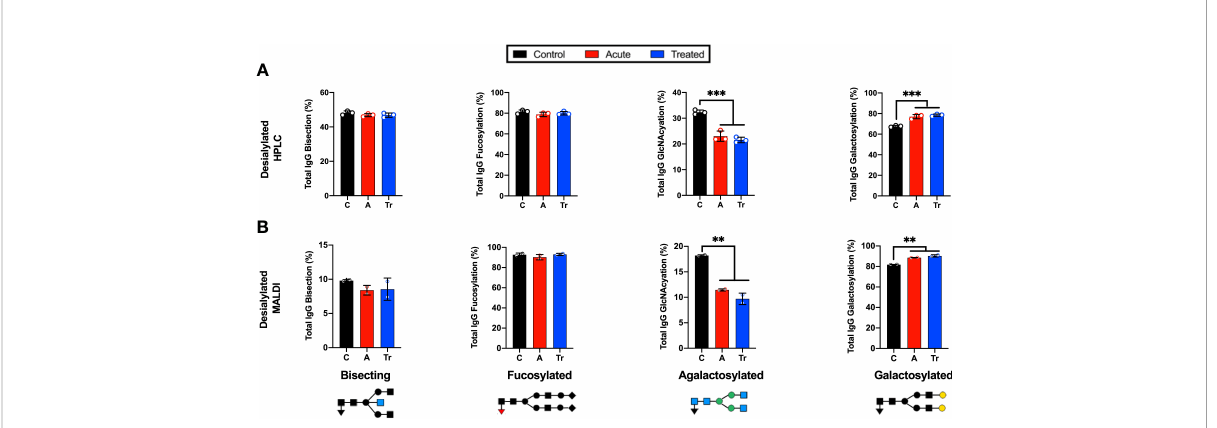
FIGURE 2 Grouping IgG N-glycans by class reveals MALDI and HPLC detect similar trends during LD (A) Labeled N-glycan classes: Bisecting, Fucosylated, Agalactosylated, Galactosylated, Sialylated detected using HPLC analysis of desialylated IgG N-glycans grouped by class averaged from 3